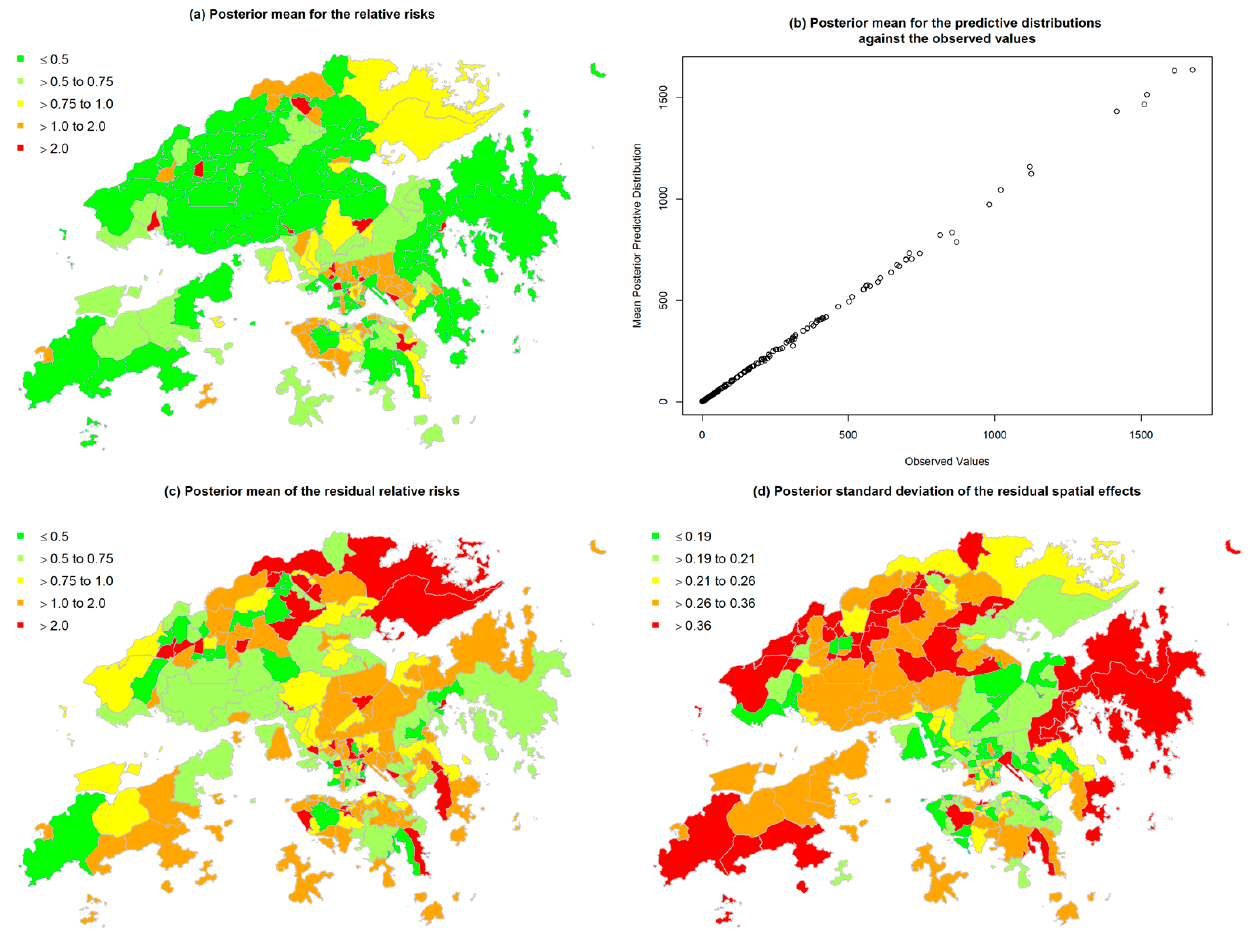
Figure 6. Posterior means of the relative risks for non-accidental mortality obtained with the multi- variable model using INLA.